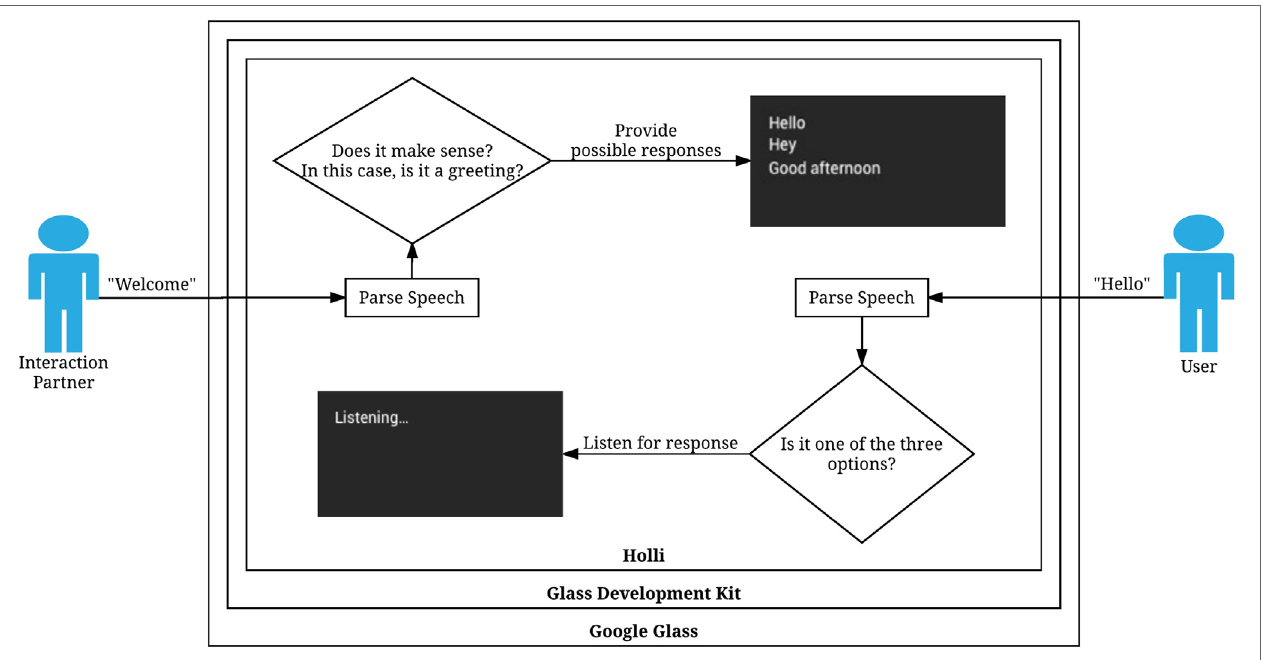
FigUre 5 | Overview of the Holli